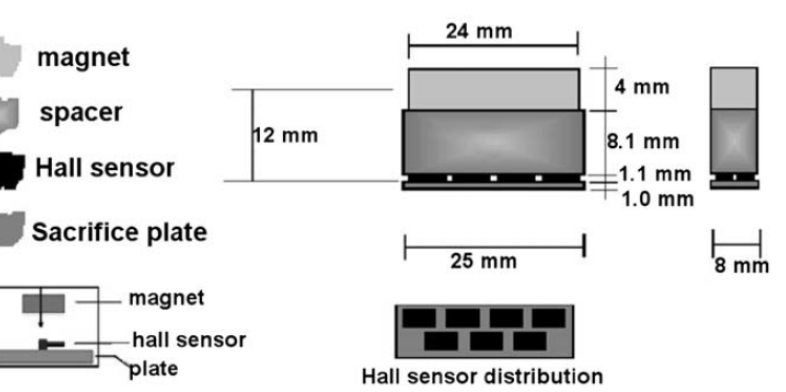
Figure 25. The schematic drawing of the ICS sensor. Reprinted from NDT & E International, Volume 42, Gloria, N.B.S.; Areiza, M.C.L.; Miranda, I.V.J.; Rebello, J.M.A. Development of a Magnetic Sensor for Detection and Sizing of Internal Pipeline Corrosion Defects, Page 669–677, Year 2009 with permission from Elsevier [102].